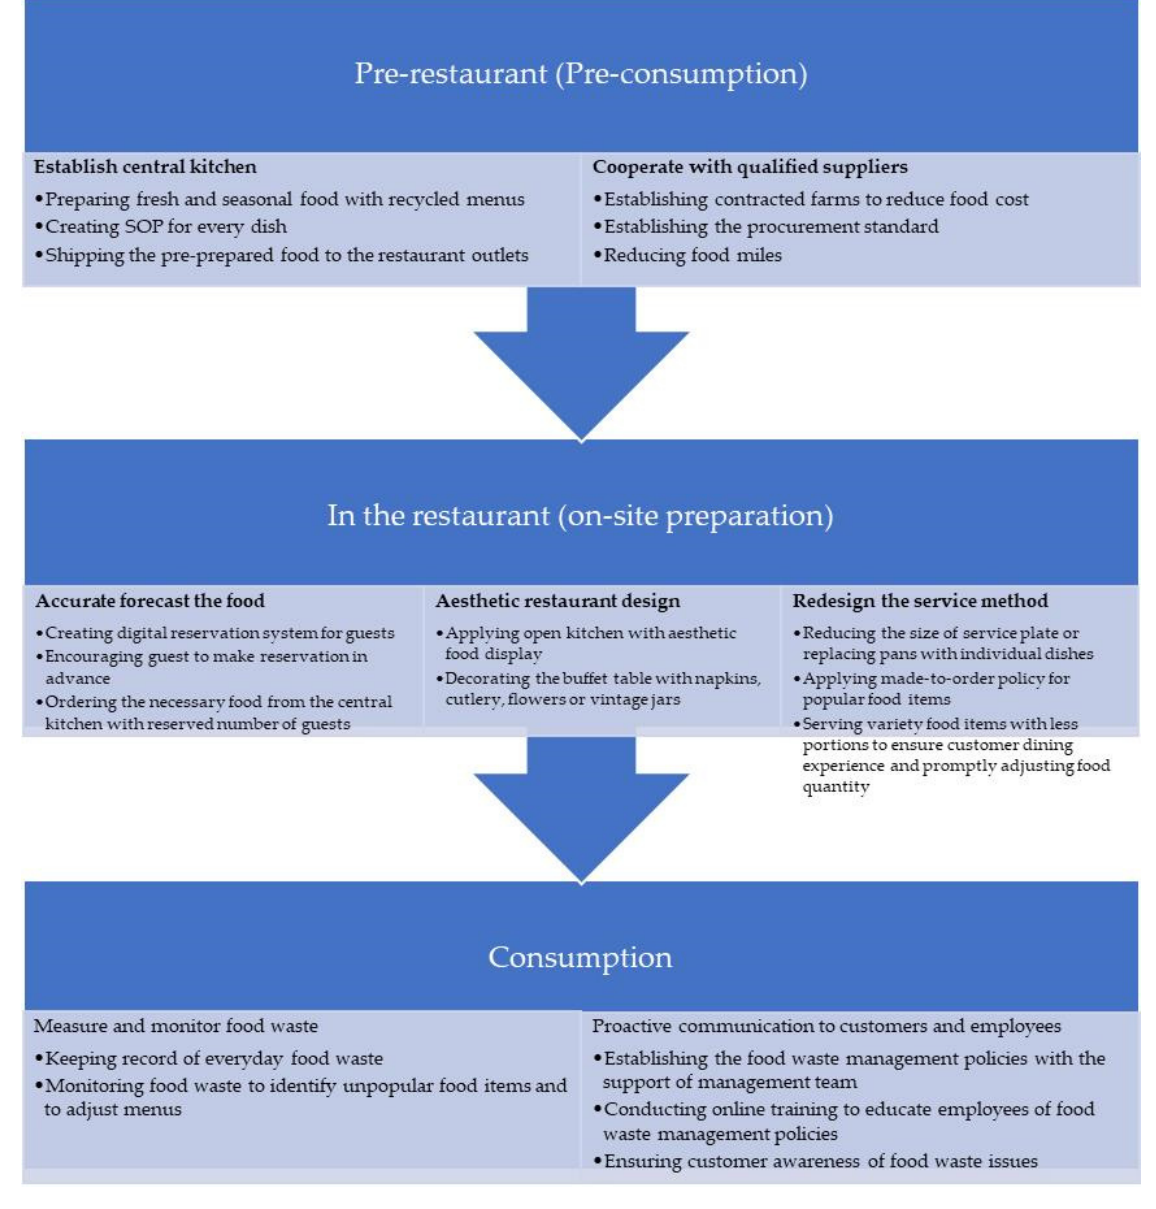
Figure 1. Corporate management approach to the reduction of food waste in buffet restaurant.